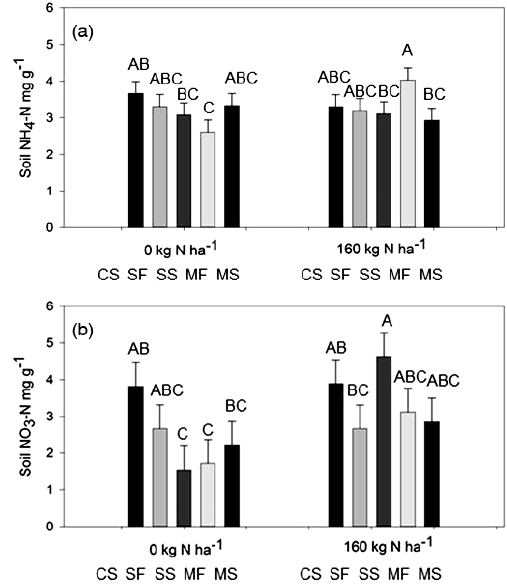
Figure 2. Mean soil NH 4 -N and NO 3 -N (mgg − 1 dry soil ± SE) in annual and perennial biomass cropping systems under var- ied harvest and N management at the Elora Research